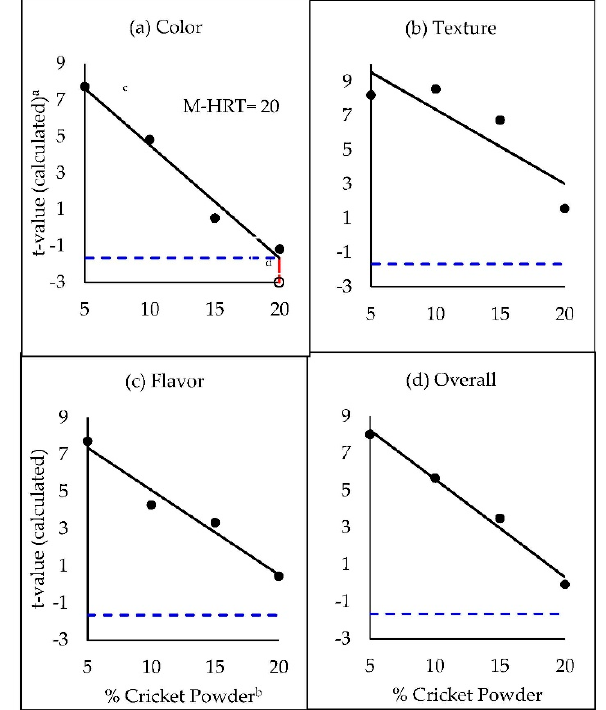
Figure 3. Modified hedonic rejection thresholds (M-HRT) for cricket powder in whole-wheat snack crackers. Thresholds were measured based on liking (a 9-point hedonic scale) of ( a ) color, ( b ) texture, ( c ) flavor, and ( d ) overall liking. a T-values were calculated from di ff erence of mean liking scores (a 9-point scale) from a score of 5. b Percentage of cricket powder used in place of whole-wheat flour ( w / w ) in cracker formulations. c Black solid lines represent a simple linear regression of t -values (y) as a function of % cricket powder (x), and black dots represent observed t -values at each treatment level. d Vertical red line represents the M-HRT, which was interpolated as the % cricket powder associated with a critical predicted t -value ( α = 0.05) of 1.67 (blue dashed horizontal line) from the simple linear regression (not found for texture, flavor, or overall liking).